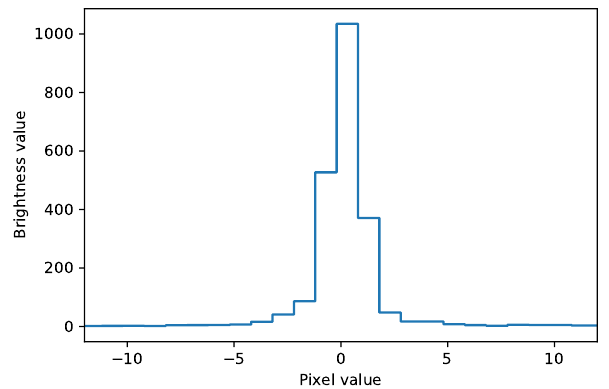
Fig. 8.— Brightness profile of the bright star near the bottom center of figure 6 of a point source is called the point-spread function , ab- breviated PSF.